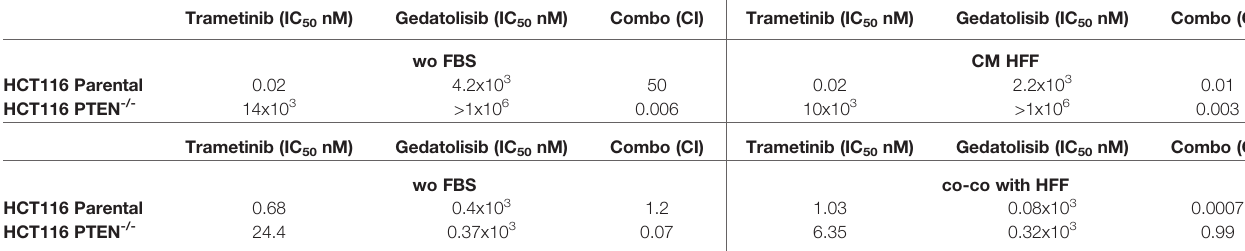
TABLE 1 | Response of HCT116 Parental and HCT116 PTEN -/- cells to targeted inhibitors under different conditions of